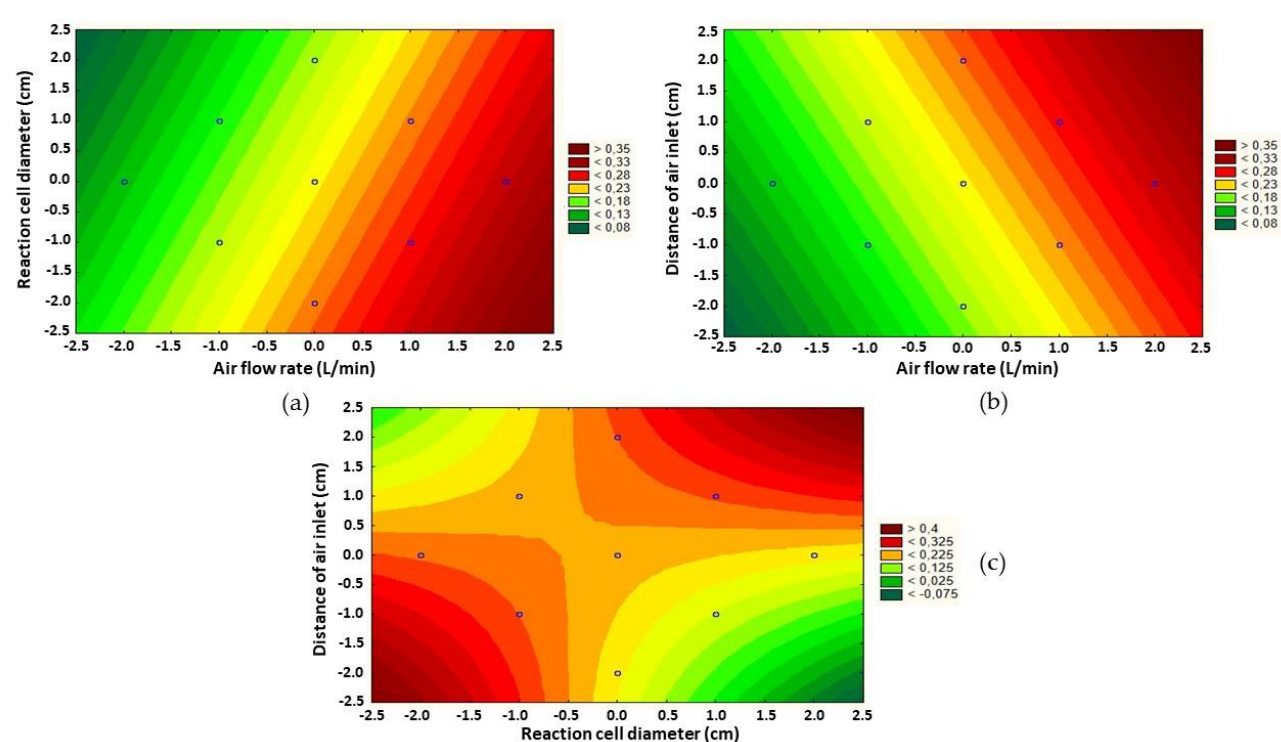
Figure 22. 2D contour graph of interaction effects for the upper air inlet and outlet geometry. Simultaneous effects on velocity exerted by ( a ) reaction cell diameter and air flow rate; ( b ) distance of air inlet and air flow rate; ( c ) distance of air inlet and reaction cell diameter.